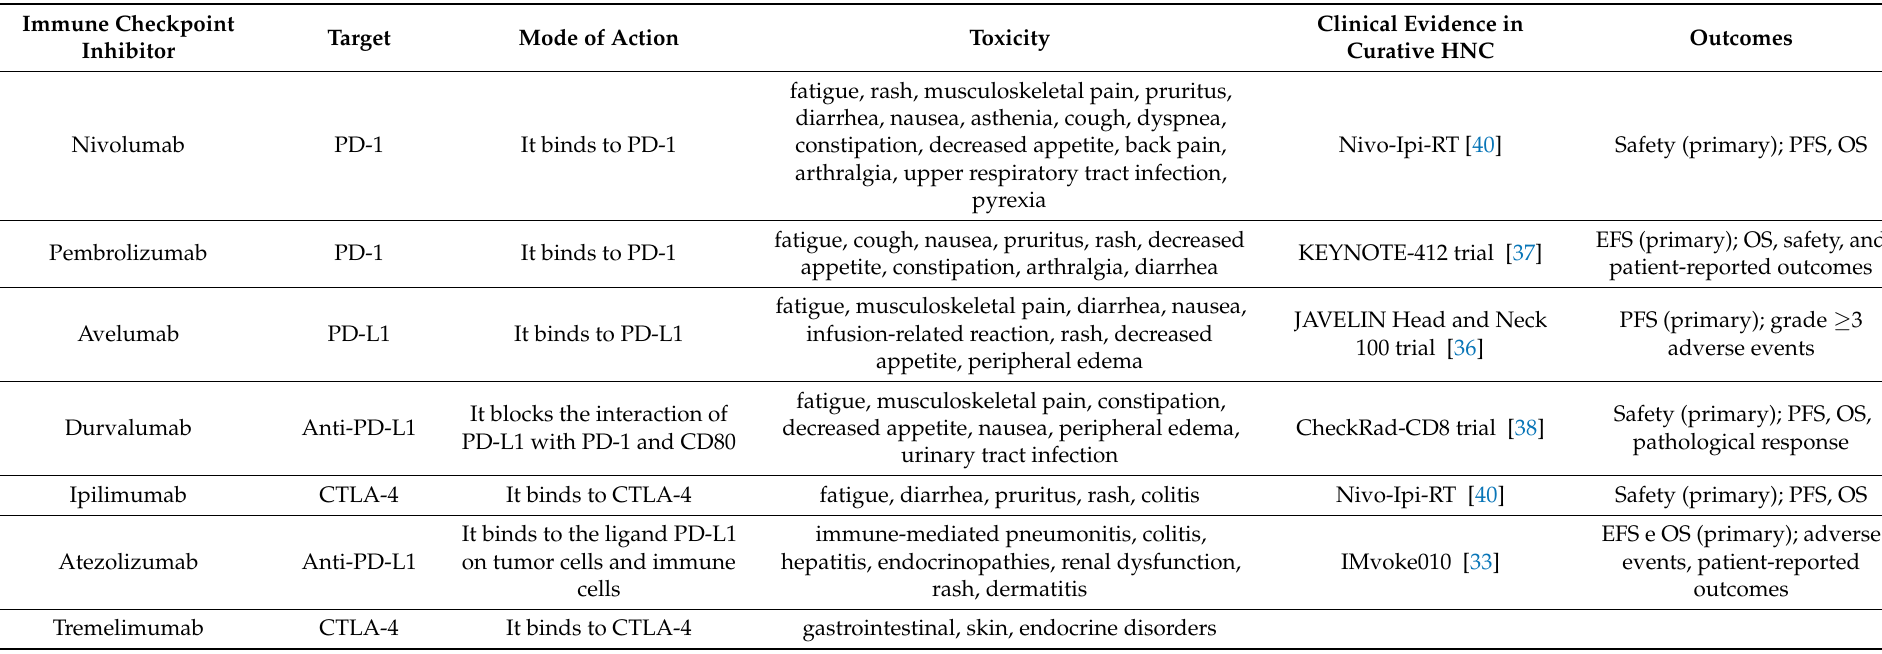
Table 1. Main characteristics of immune check-point inhibitors in a curative HNC